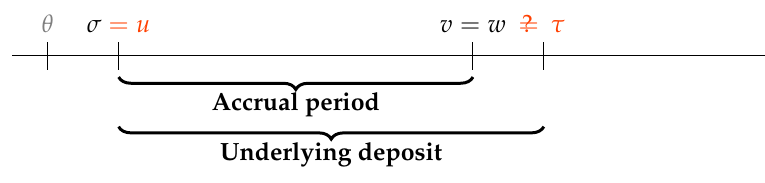
Figure 1. Representation of the dates associated to a LIBOR fixing and a LIBOR coupon in a vanilla